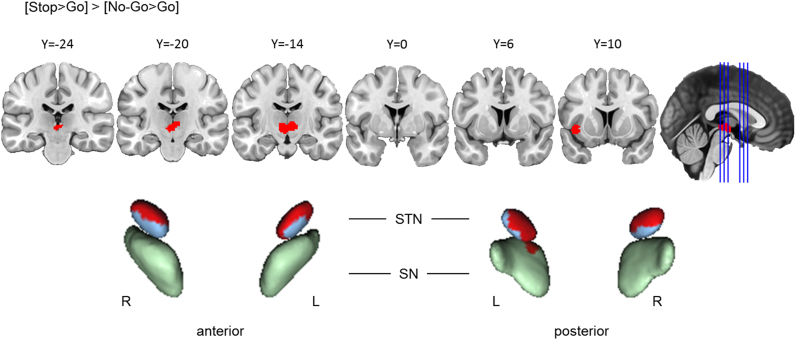
Action cancellation reliably engaged STN and SN more than action prevention. Top row: Clusters are presented on coronal slices of a high-resolution MNI atlas. Reference lines for the coronal slices are presented in the sagittal plane. Bottom row: Clusters are displayed on high-resolution parcellaions of the subthalamic nucleus (STN) and substantia nigra (SN). The contrast analysis was computed using the thresholded ALE images from the individual analyses. All clusters are thresholded at uncorrected p<.001, with the p-value permutations of 10,000 iterations, and the minimum cluster volume of 200 mm3.